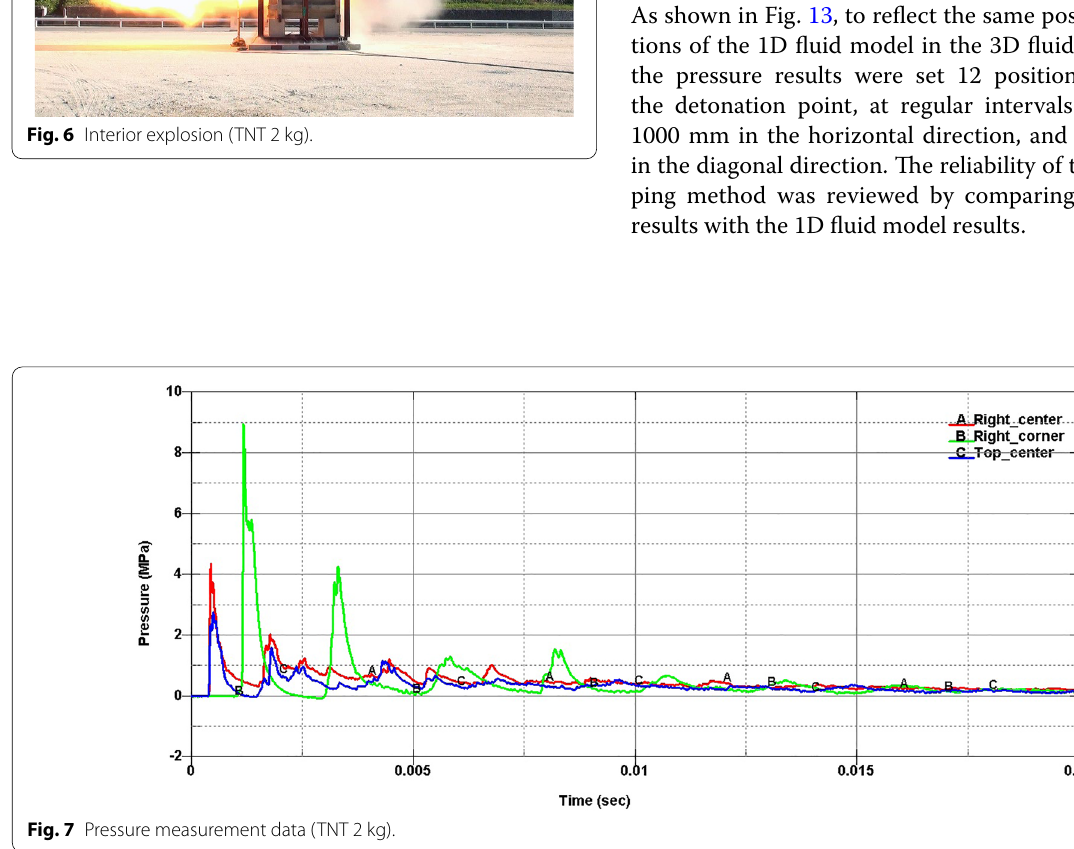
Fig. 7 Pressure measurement data (TNT 2 kg).